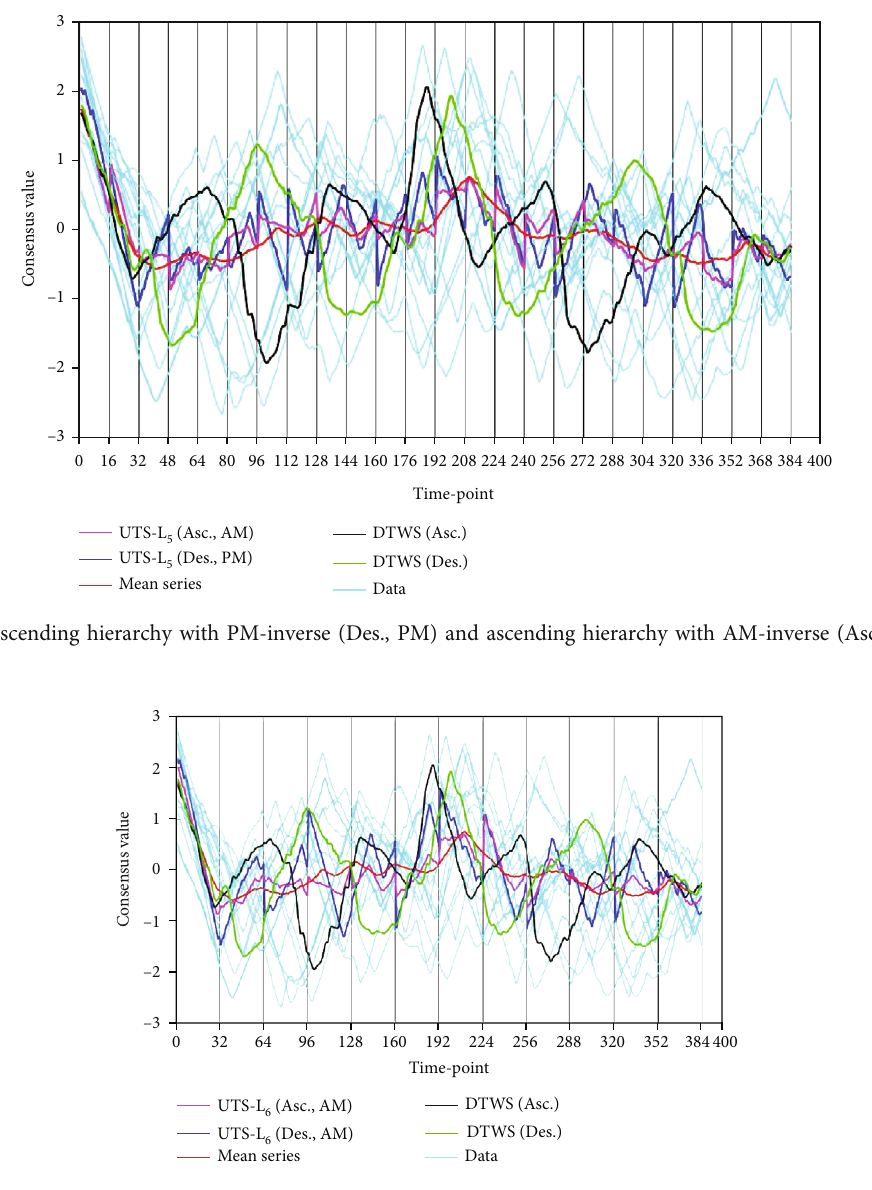
Figure 9: UTS- L : ascending hierarchy with AM-inverse (Asc., AM) and descending hierarchy with PM-inverse (Des., PM). Data track: 6 OSULeaf